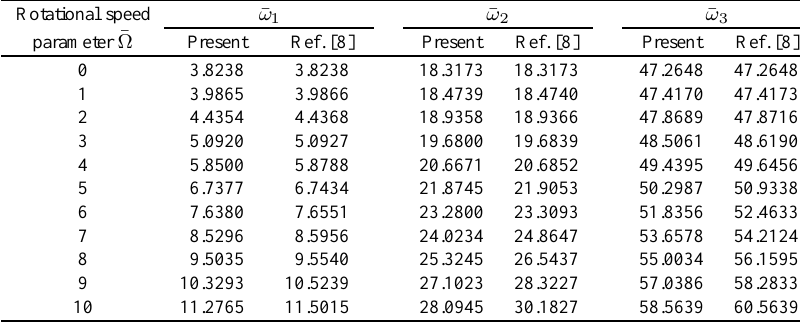
Effect of rotation on the frequency parameters of rotating tapered cantilever beam for τ b = 0 . 0 and τ h = 0 . 5 and ¯ R =